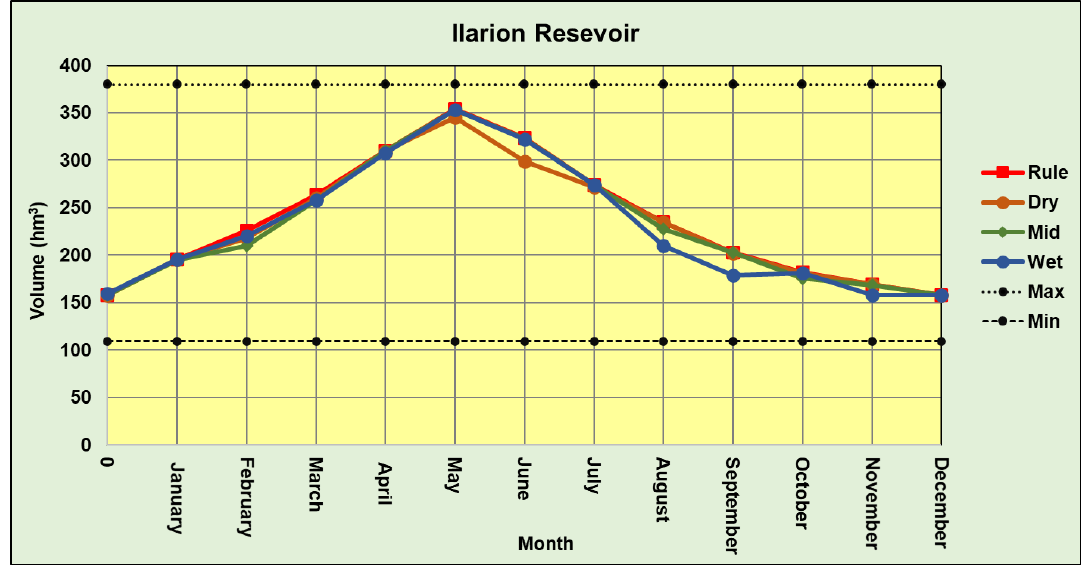
Figure 10. Monthly hydro energy production of the Aliakmon’s system, ignoring the institutional operating rule curves.